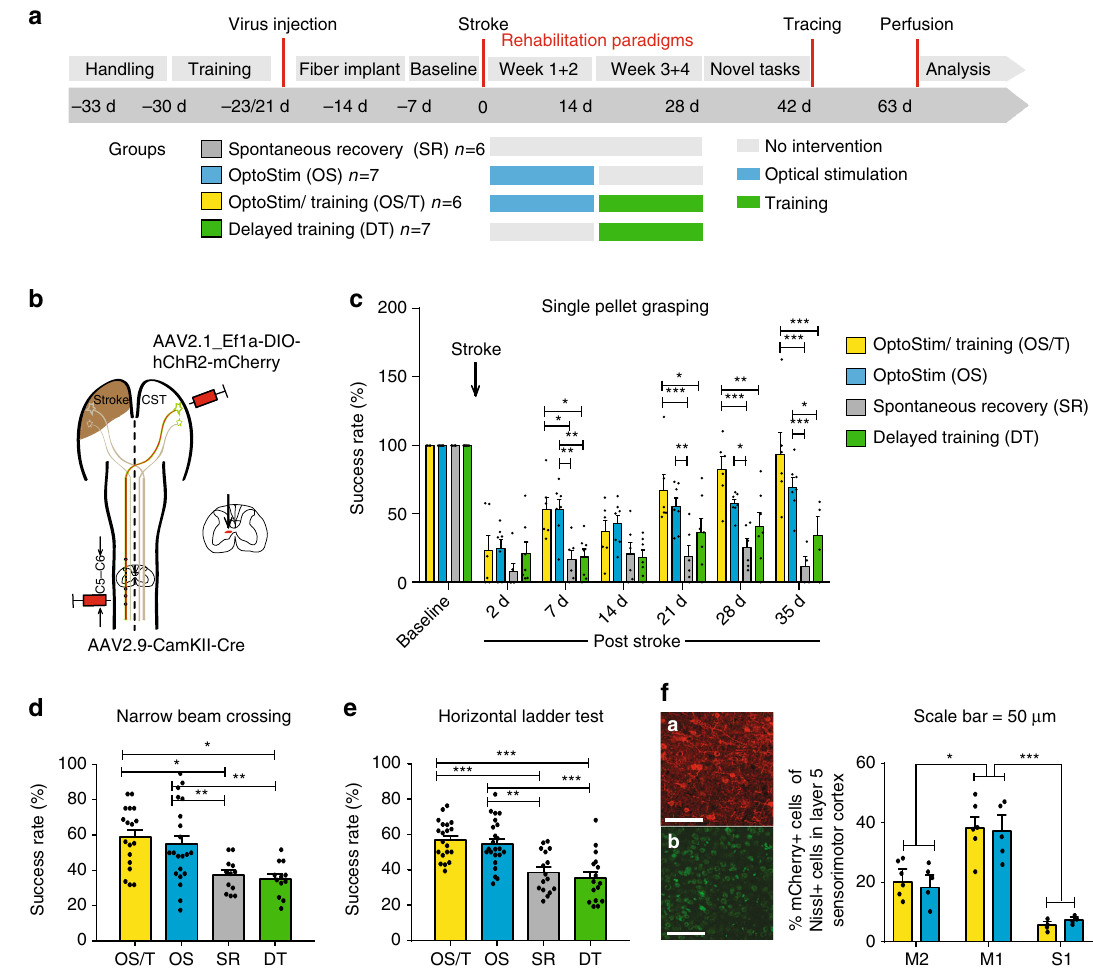
Fig. 1 Speci fi c optogenetic stimulation of the intact corticospinal tract originating from the contralesional hemisphere results in robust recovery of lost forelimb function after stroke. a Timeline for the four different treatment groups. b Schematic diagram of viral vector injections into the contralesional motor cortex (AAV2.1-Ef1a-DIO-hChR2(t159C)-mCherry) and the corresponding cervical hemi-spinal cord (AAV2.9-CamKII0.4.Cre.SV40) to speci fi cally express Channelrhodopsin-2 (ChR2) in the intact corticospinal neurons. c Success rates in the single pellet grasping task relative to baseline (100%; intact, trained) 2 days to 5 weeks after a large, unilateral photothrombotic stroke to the sensorimotor cortex of the preferred paw. The “ OptoStim/Training ” and “ OptoStim ” groups showed signi fi cant improvement of skilled forelimb function compared to the other groups. Both stimulation groups ( “ OptoStim ” and “ OptoStim/Training ” group) also performed signi fi cantly better in novel tasks to assess recovery of forelimb function such as the narrow beam task ( d ) and the horizontal ladder crossing task ( e ) tested at 5 weeks after stroke. Shown are average success rates of three consecutive trials. f Representative images of mCherry-positive cells ( a ) in the sensorimotor cortex in comparison to Nissl-positive cells ( b ) ( a , b : scale bars = 50 μ m) as well as quanti fi cation of mCherry-positive cells in percentage of Nissl-positive cells in layer 5 of pre- (M2), primary motor cortex (M1), and primary sensory cortex (S1) for both “ stimulation ” groups. Data are presented as means ± s.e.m.; statistical evaluation was carried out with two-way (for c ) and one-way (for d , e ) ANOVA repeated measure followed by Bonferroni post hoc, and with paired t -test, two-tailed for F; asterisks indicate signi fi cances: * p < 0.05, ** p < 0.01, and *** p <